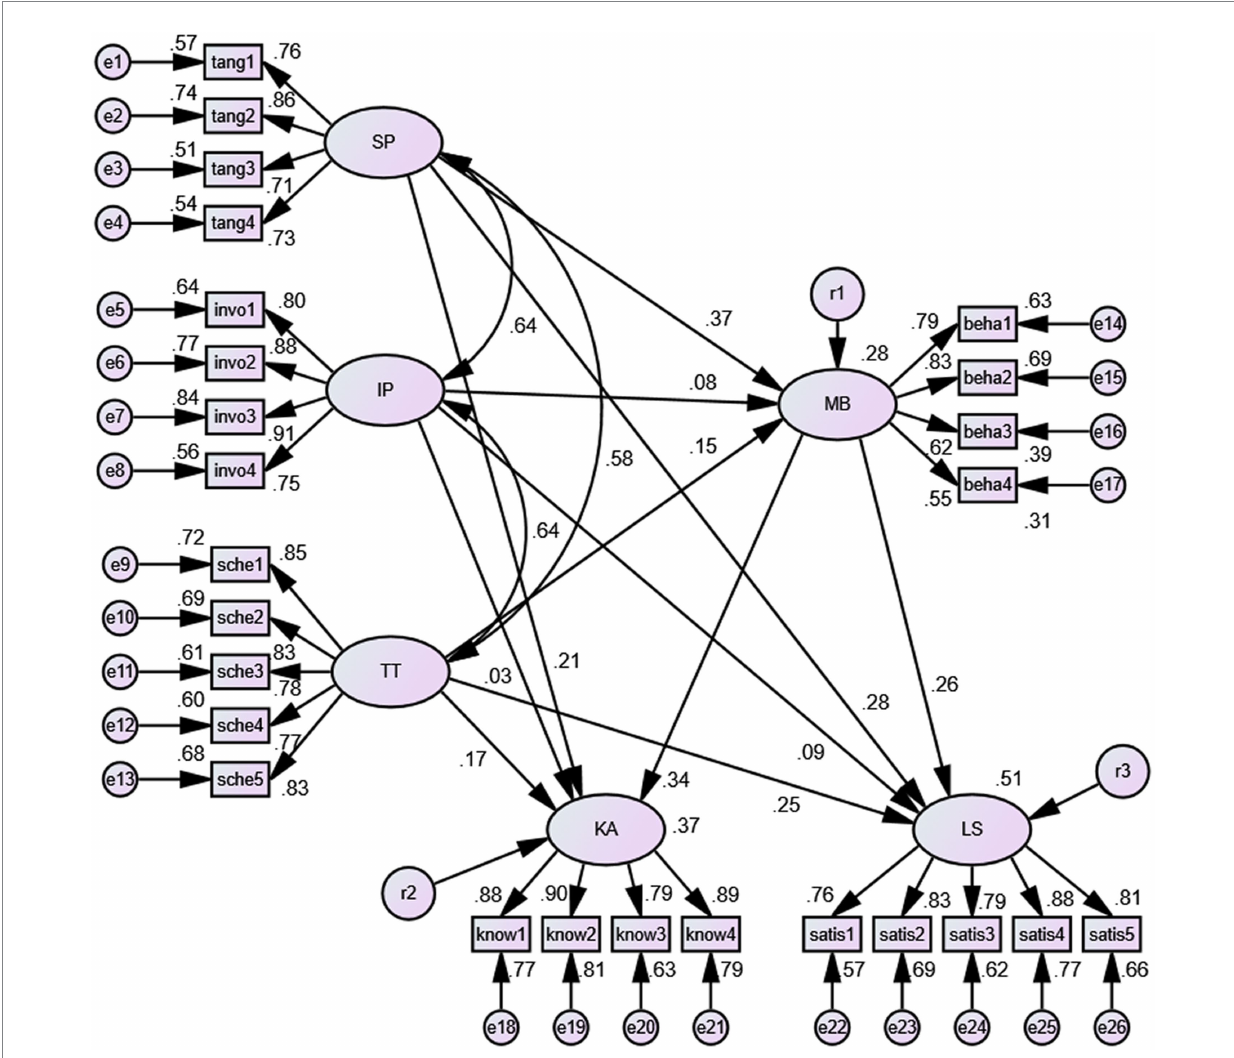
FIGURE 3 The standardization coefficient pattern of the SEM for the college student sample. SP = Scheduling preference, IP = Involvement with people, TT = Time tangibility, MB = Multitasking behavior, KA = Knowledge acquisition, LS = Learning